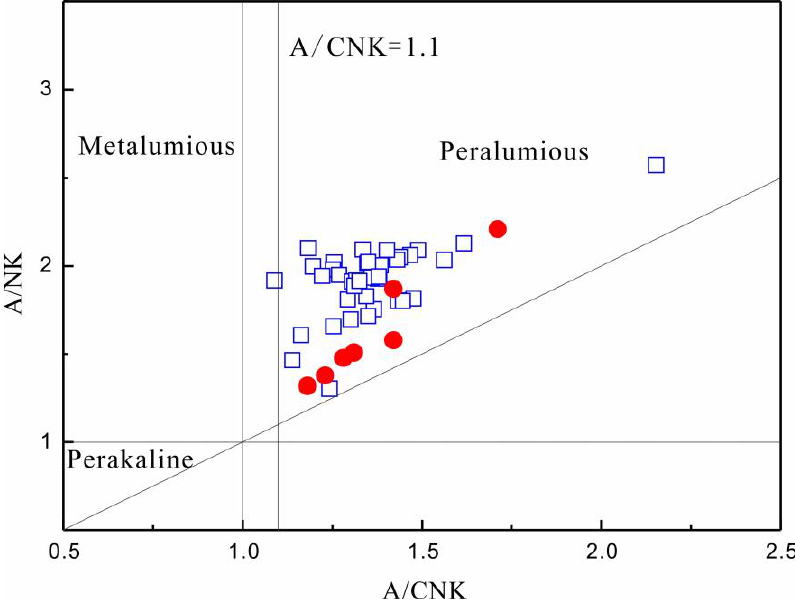
Figure 4. Diagram of Al saturation index of Jiningian granodiorite in the Dahutang deposit (modified after [40]). Previous data from [20,21,38,39], as shown in Table S2.